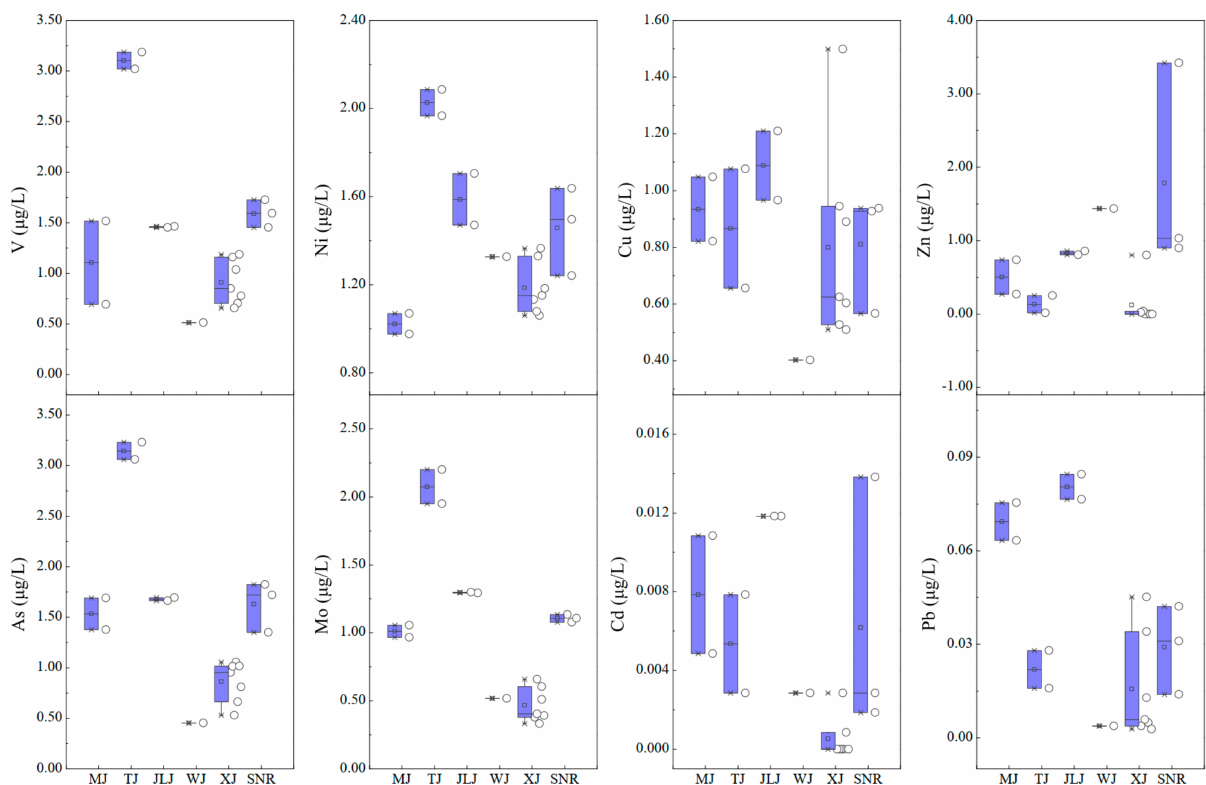
Figure 3. Spatial distribution of concentrations of eight HMs in tributaries of the upper TGR